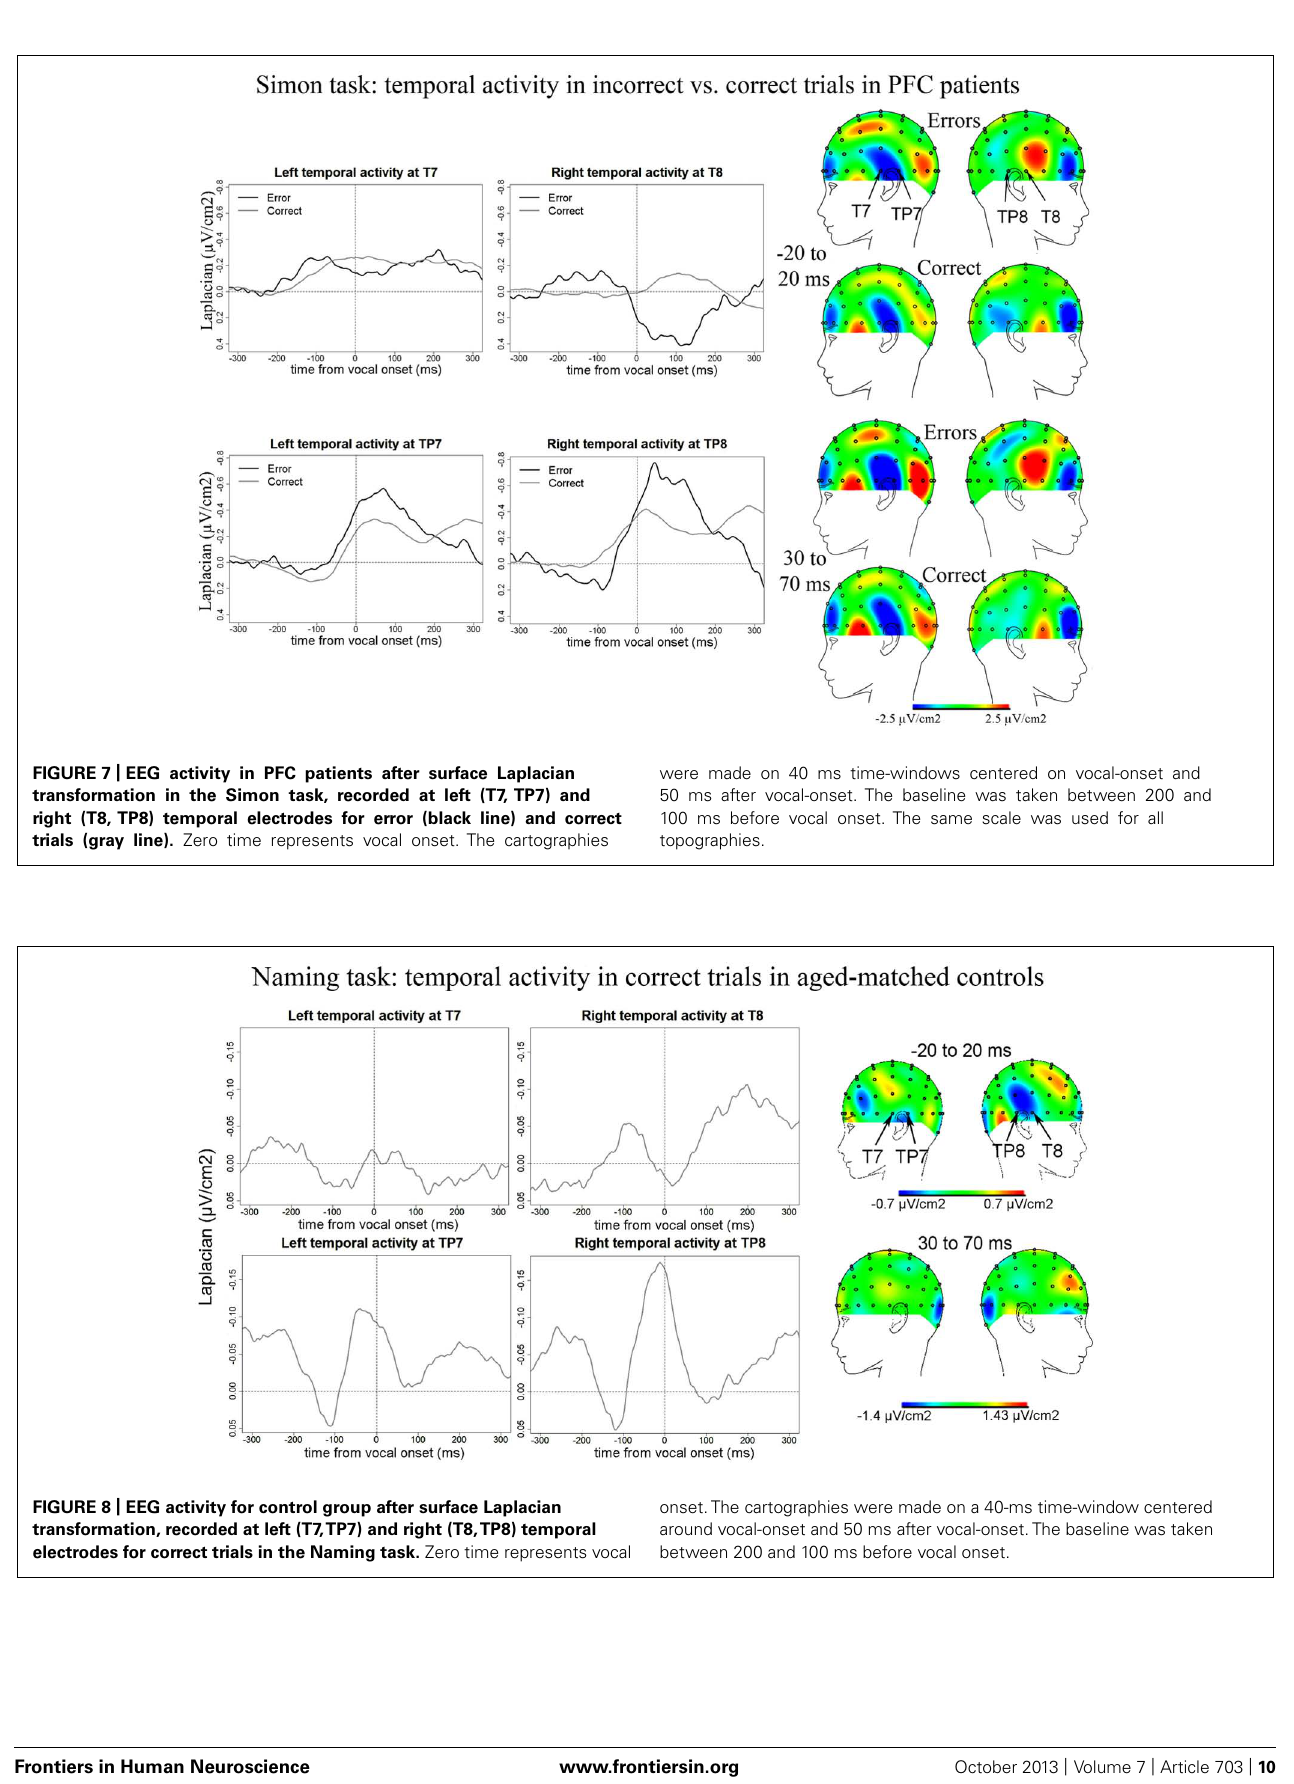
onset.The cartographies were made on a 40-ms time-window centered around vocal-onset and 50 ms after vocal-onset.The baseline was taken between 200 and 100 ms before vocal